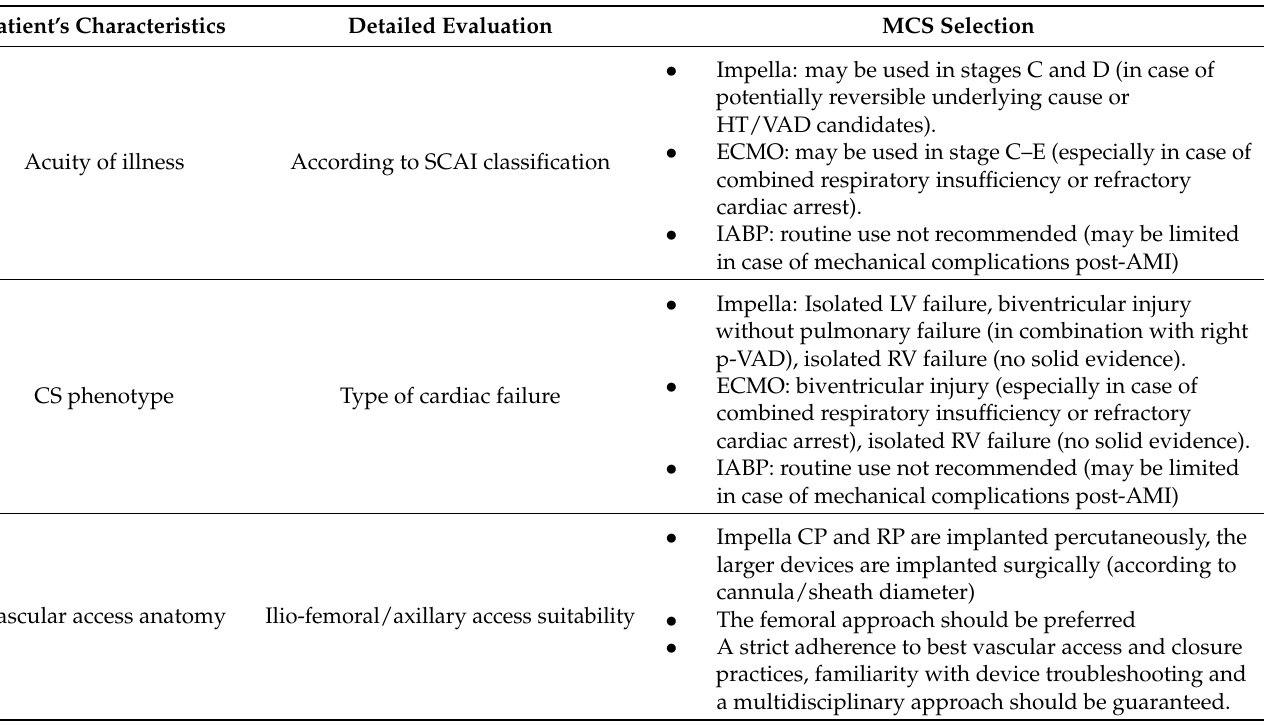
Table 3. Key factors that should be evaluated when choosing the type of mechanical cardiac support to restore proper coronary and end-organ perfusion in case of in infarct-related